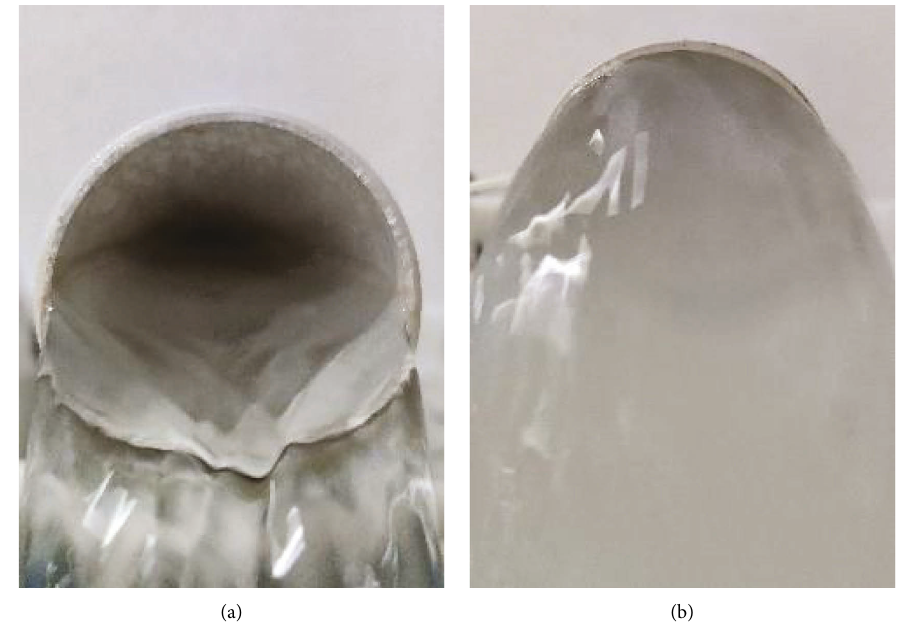
Figure 11: Photos of drainpipes in different water filling states. (a) Semi-filled state. (b) Full-filled